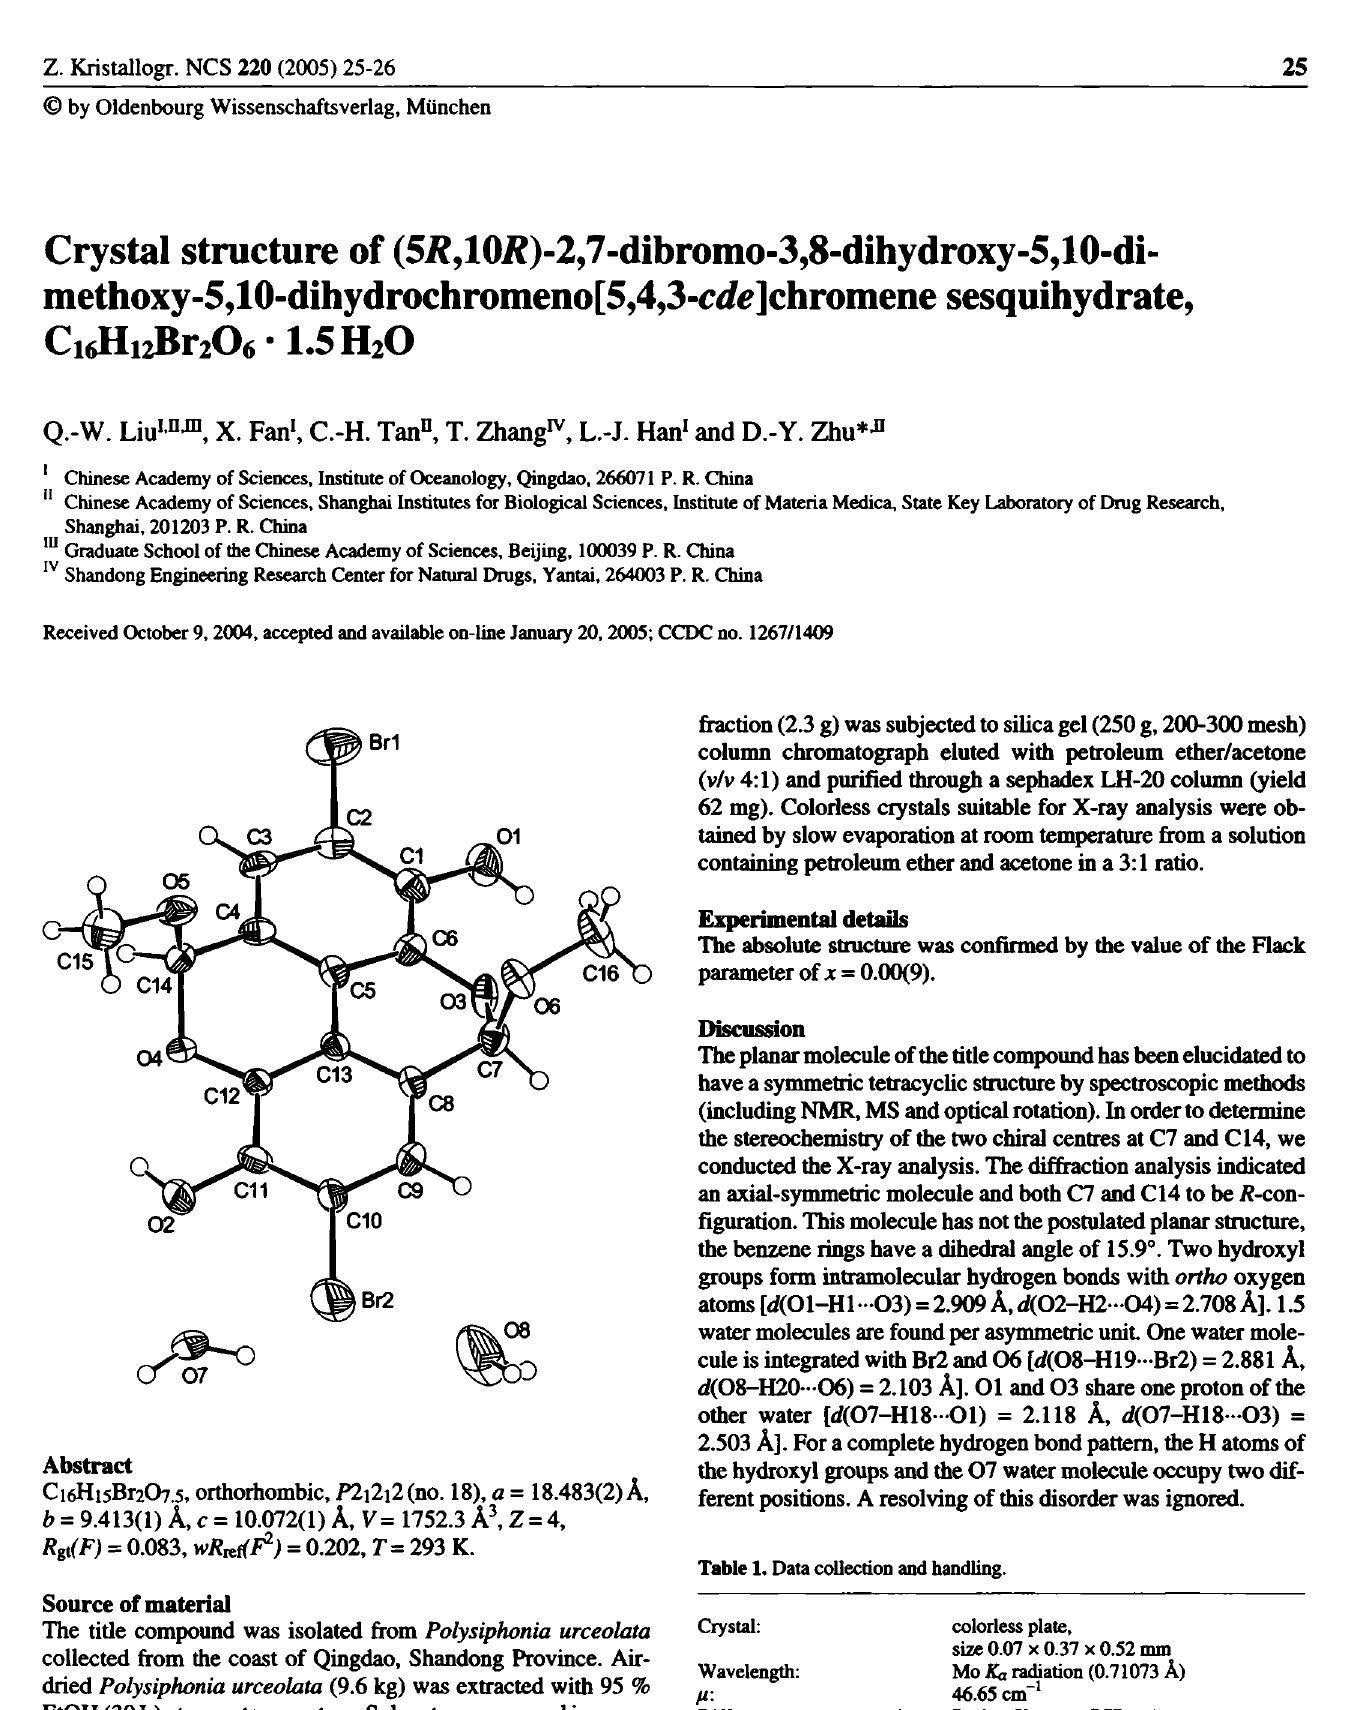
Table 1. Data collection and